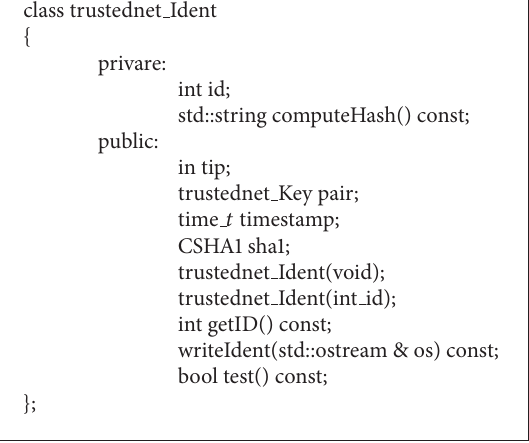
Algorithm 1: Program code of the class trustednet ident.